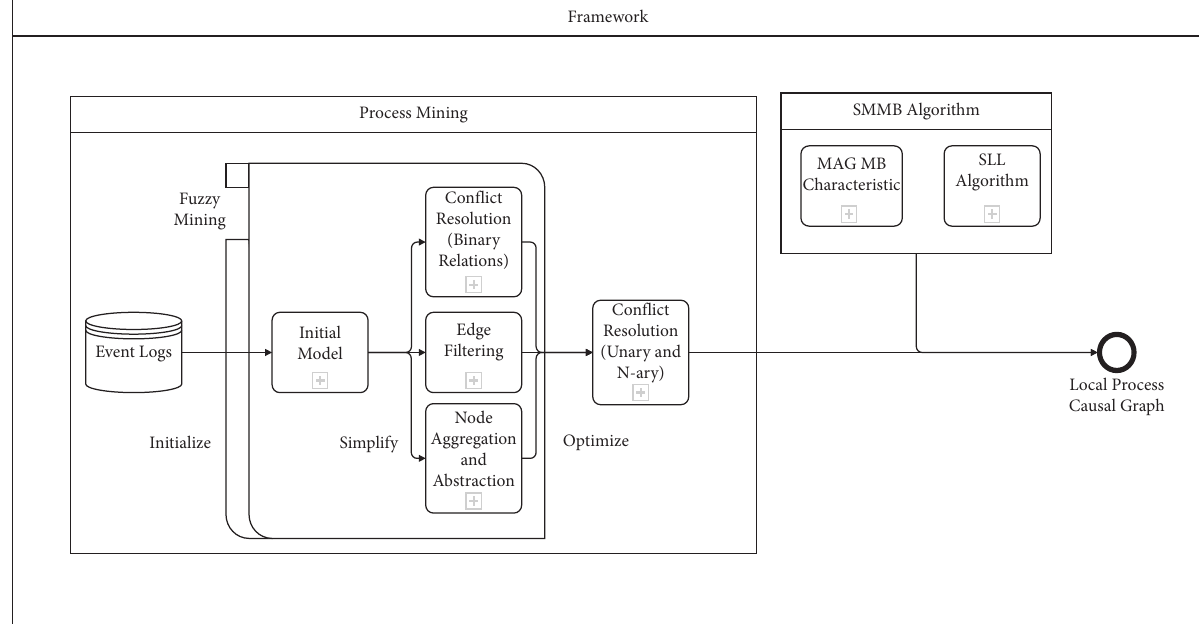
Figure 1: Automatic discovery framework of causal factors based on process